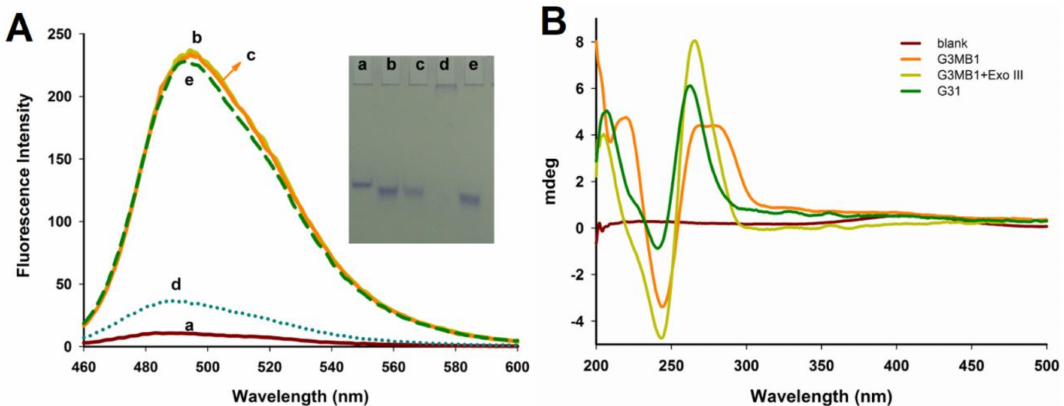
Figure 1. The feasibility of the G3MB1-b biosensor. ( A ) Fluorescence spectra at different conditions: (a) G3MB1 and ThT; (b) G3MB1, Exo III and ThT; (c) G3MB1-b, Exo III and ThT; (d) G3MB1-b, Exo III, SA and ThT; (e) G3MB1, Exo III, SA and ThT. The excitation wavelength was set at 435 nm, and the fluorescence spectra was collected from 460 nm to 600 nm at room temperature. Insert: the agarose gel electrophoresis image. The electrophoresis was carried out in 1 X Tris-borate-EDTA (TBE) buffer at 150 V power for about 3 h at room temperature. ( B ) CD spectra of G3MB1 in the absence and presence of Exo III. The results were accumulated and collected from 200 to 500 nm, speed of 200 nm/min, bandwidth of 1.0 nm, and response time of 0.5